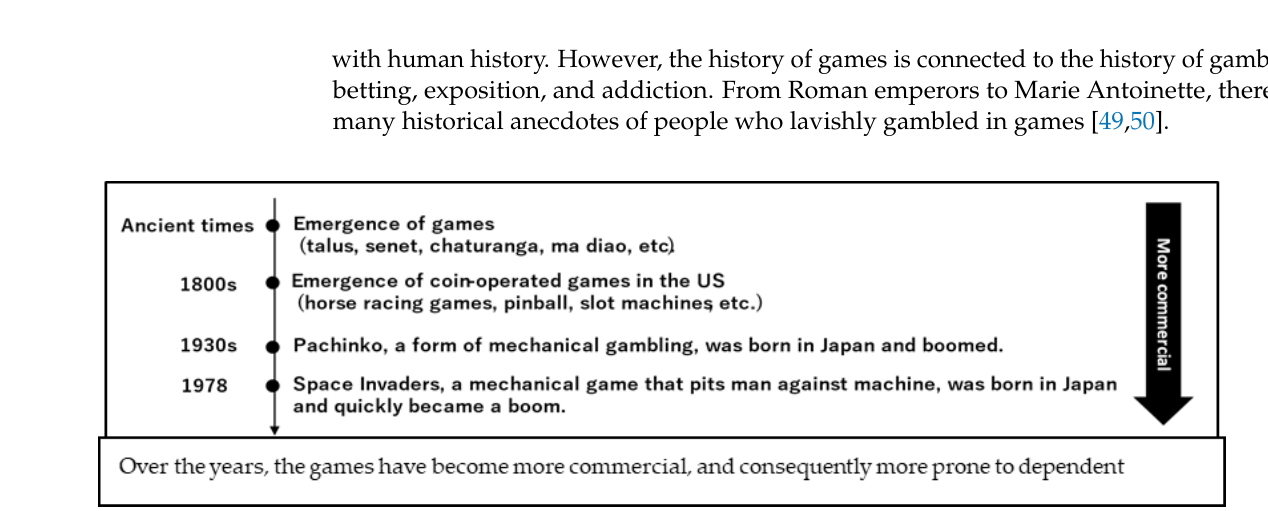
Figure 2. History of gaming: From “ person vs. person ” to “ person vs. machine ” .